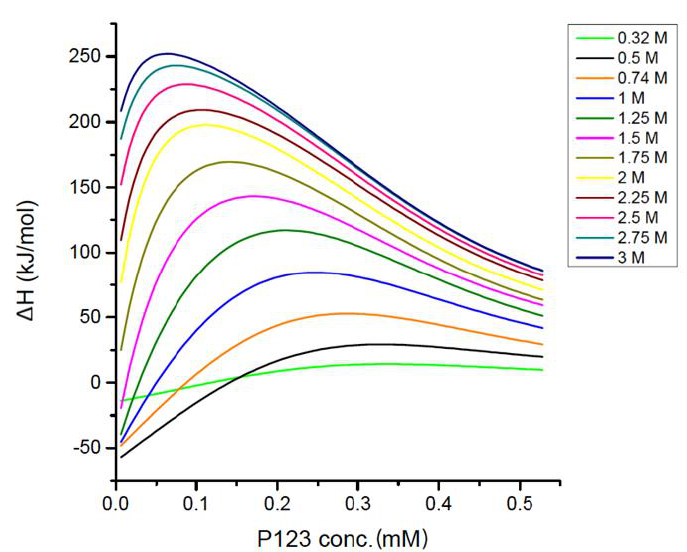
Figure 9. Enthalpy of Pluronic P123 and EAN interaction during micellization plotted as a function of Pluronic concentration. The interaction enthalpy is obtained by subtracting the EAN dilution enthalpy and the enthalpy of Pluronic in water from the observed enthalpy during titrating micellar Pluronic in water into EAN aqueous solution. The titrations were conducted at varied EAN concentrations as indicated in the legend.